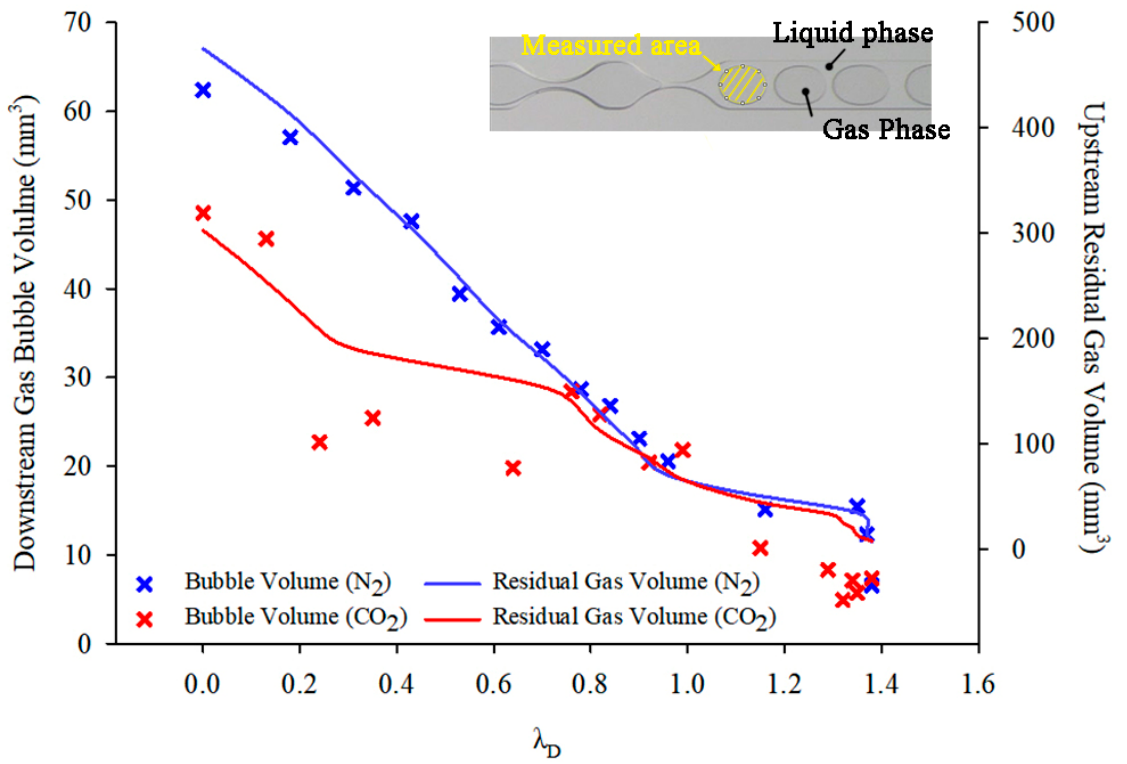
Figure 10. Gas Bubble and Residual Gas Volume Measurement.